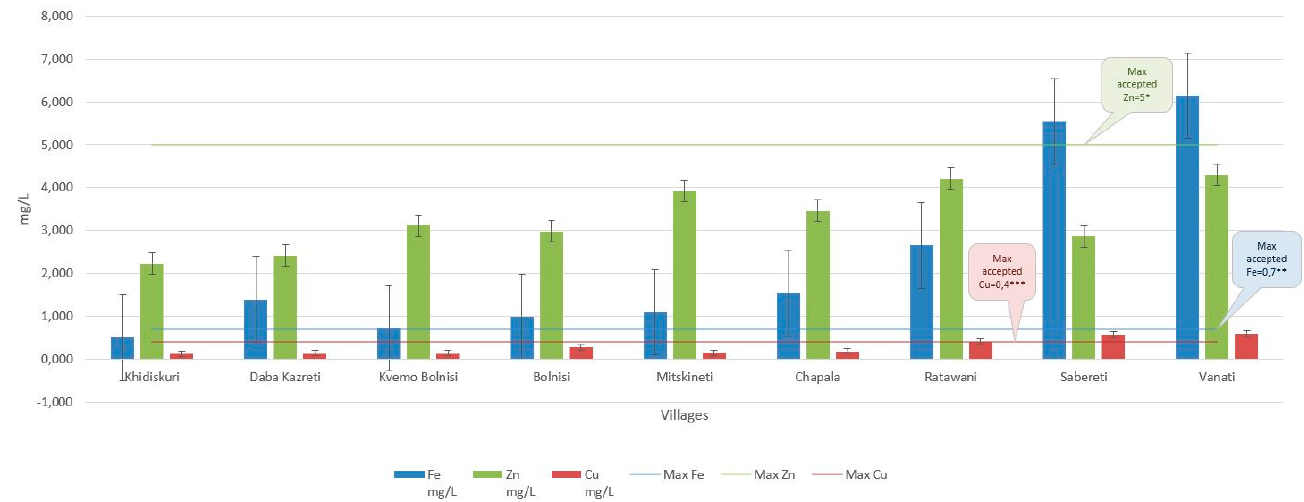
Figure 3. Concentration ranges (mg L − 1 ) of Iron, zinc and copper in milk samples (N Bolnisi = 22, N Chapala = 22, N Daba Kazreti = 24, N Kvemo Bolnisi = 24, N Khidiskuri = 22, N Mitskineti = 22, N Ratawani = 23, N Sabereti = 12, N Vanati = 24). * Maximum permissible limits for Zn, ** Maximum permissible limits for Fe, *** Maximum permissible limits for Cu.